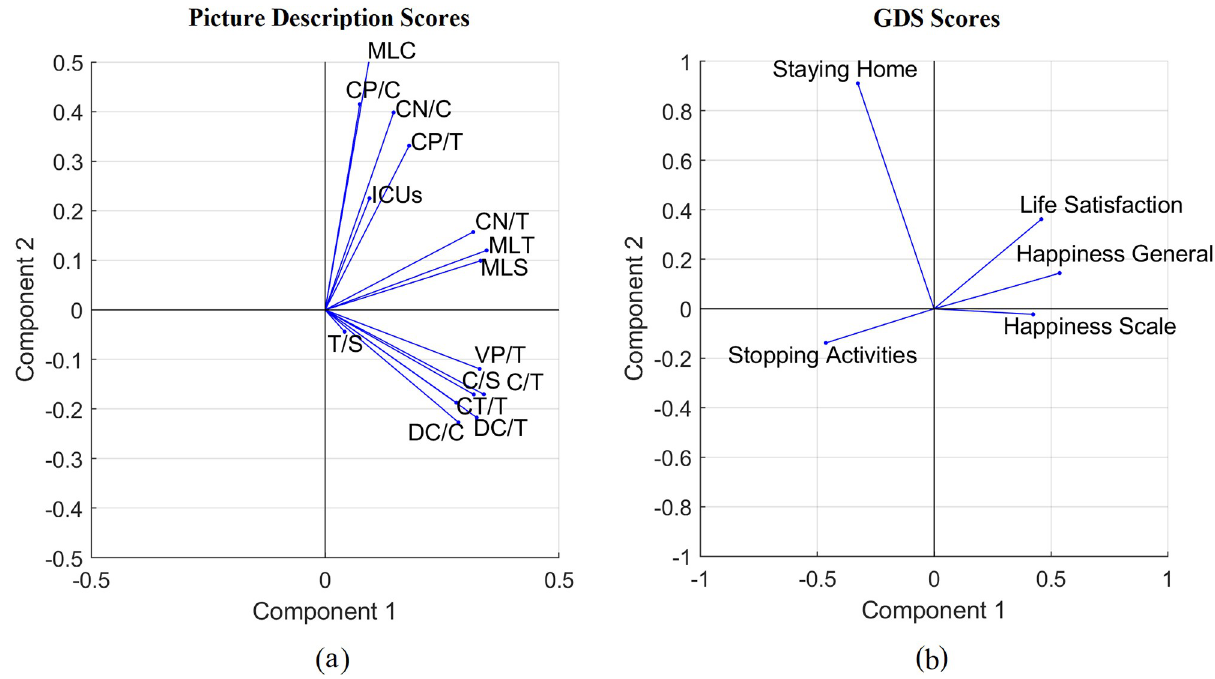
Fig 13. PCA analysis of different scores (a) Picture description, (b) GDS